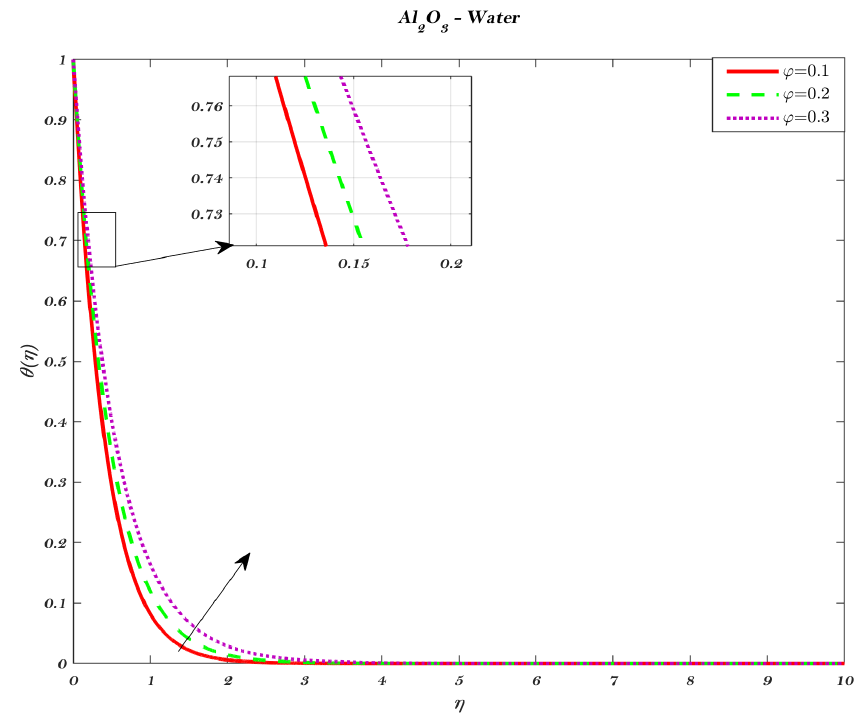
Figure 6. Temperature profile as a function of nanoparticle volume fraction ϕ with fix parameters (cid:101) = 0.02 ˘ a = 0.01, P r = 204 and R = 1.